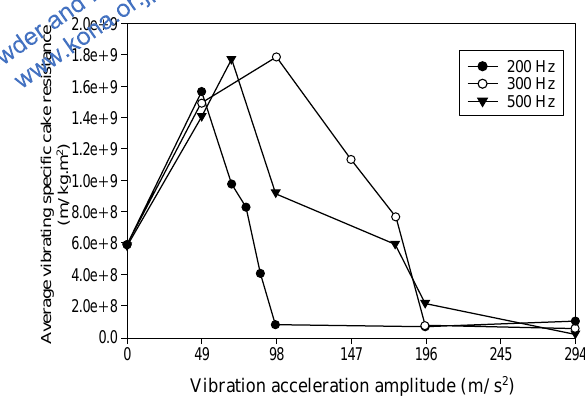
Fig. 12 Average vibrating specific cake resistance under different vibration characteristics.